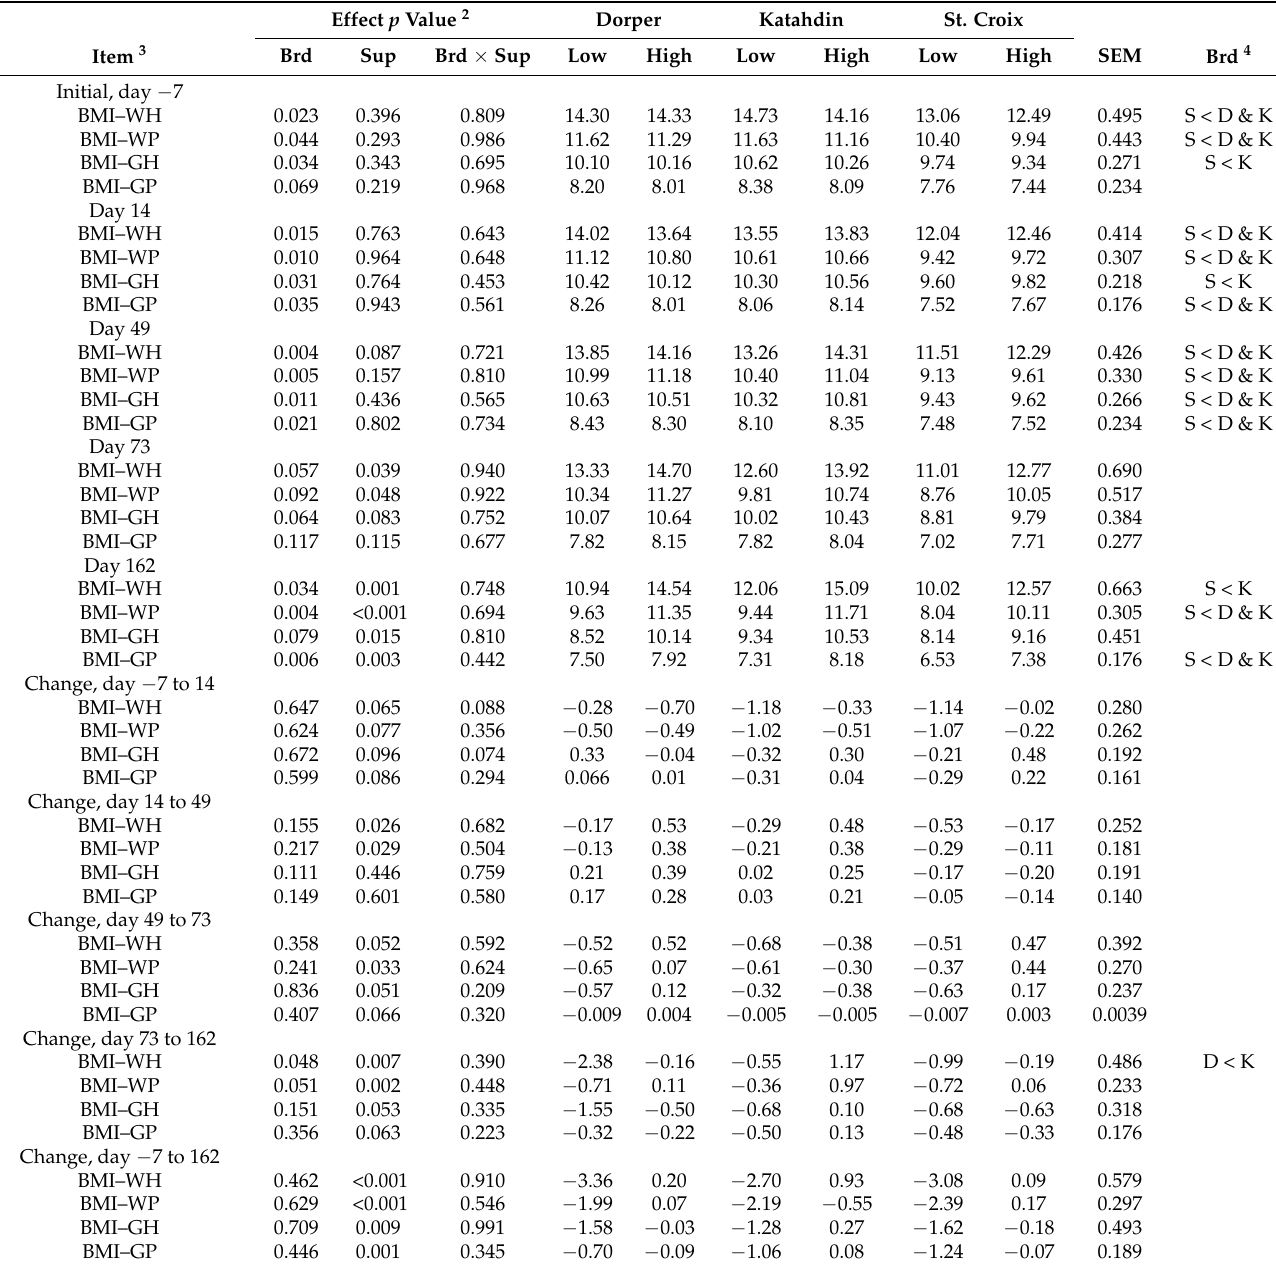
Table 5. Effects of breed and supplement treatment on body mass indexes of hair sheep 1 . Effect p Value 2